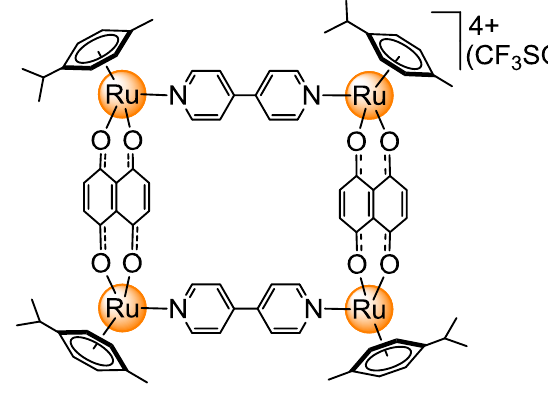
H Me) Ru (μ-dhnq) 6 4 4 4